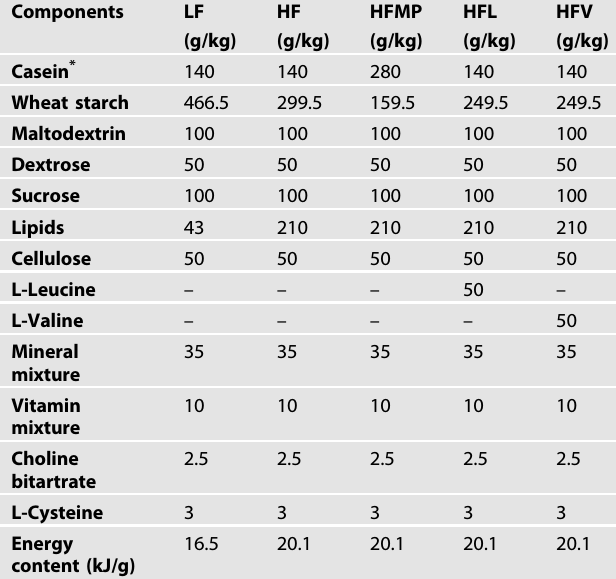
Table 1. Composition of semisynthetic experimental low-fat (LF) and 40 Energy% high-fat (HF) diets supplemented with milk protein (HFMP), leucine (HFL), or valine (HFV) produced by ssniff Spezialdiäten